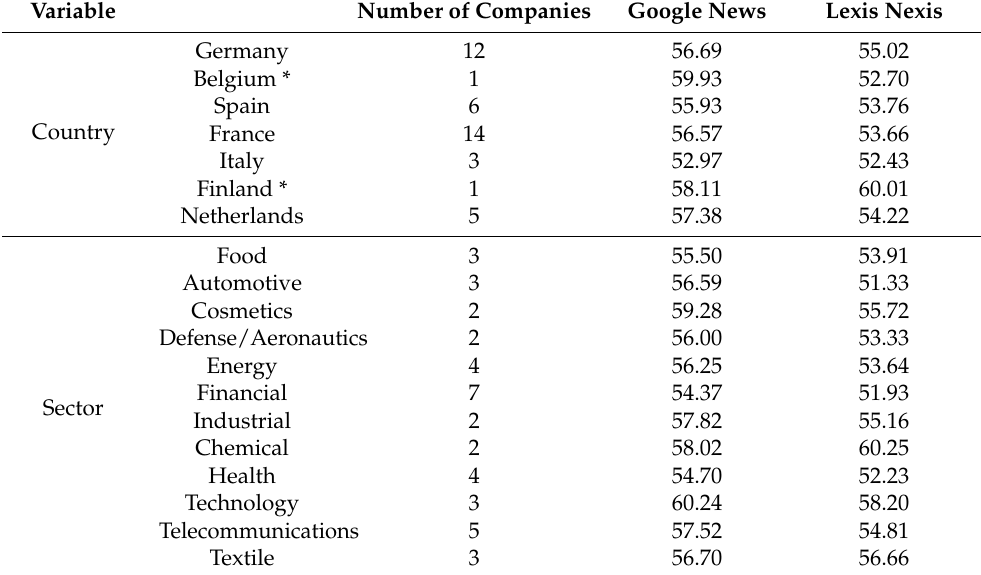
Table 3. Legitimacy by country and